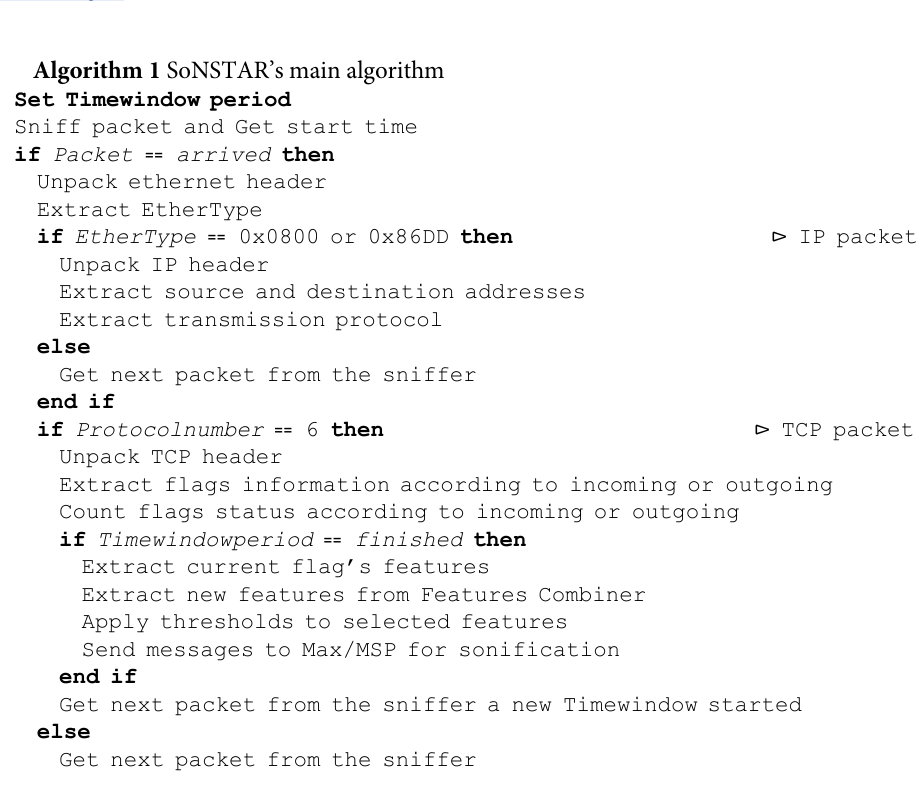
Algorithm 1 SoNSTAR’s main algorithm